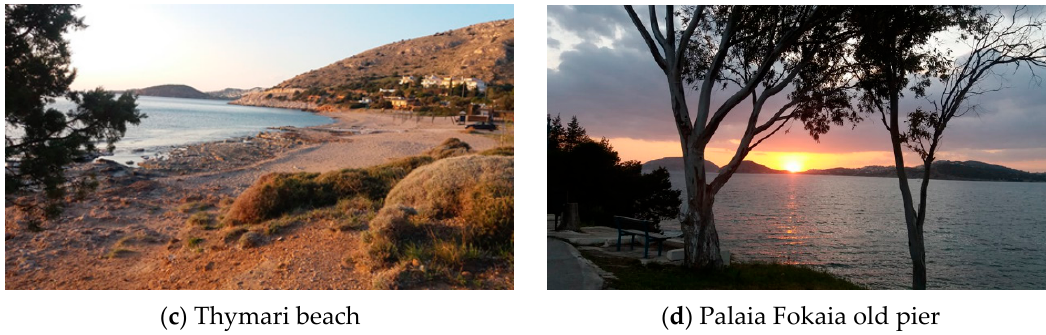
Figure 3. Views of the case study area (1, 2, 3, 4 in clockwise order on the map—see Figure 6). Source: Chryssy Potsiou’s Personal Archive.